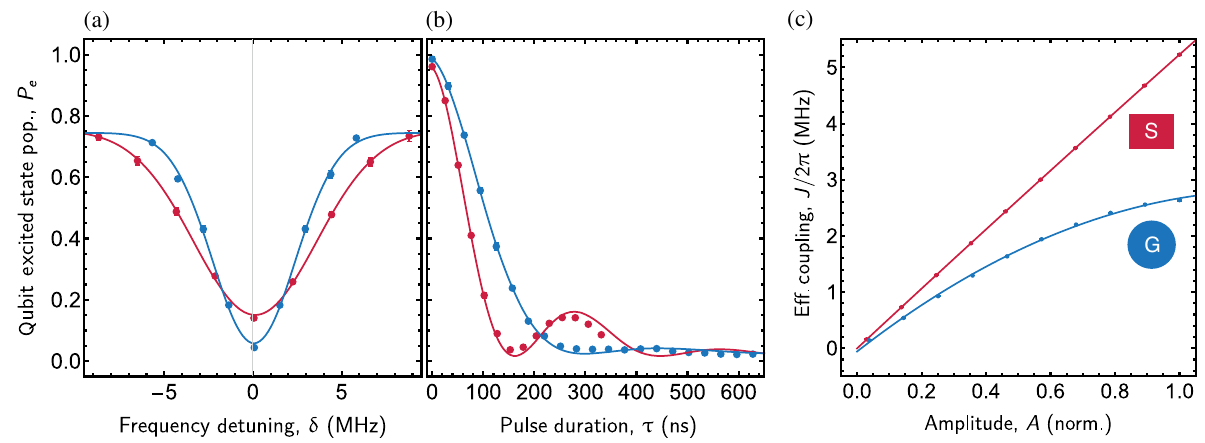
FIG. 9. (a),(b) Excited state population P after preparing the source qubit (red) [gate qubit (blue)] in the excited state and applying a e modulated flux pulse with a square envelope and a fixed, normalized amplitude of A ¼ 0 . 35 . (a) Fixed pulse duration τ ¼ 283 ns (349 ns), plotted vs flux pulse frequency detuning δ from the j e 0 i ↔ j g 1 i transition. Solid lines are Gaussian fits to the data. (b) On resonance δ ¼ 0 , plotted vs flux pulse duration τ . Solid lines are fits to the data; see the text. (c) Effective coupling rate J for the j e 0 i ↔ j g 1 i transition of the gate qubit ( G , blue circle) and the source qubit ( S , red rectangle) vs drive amplitudes A , normalized to the respective maximal amplitude. Solid lines are quadratic fits to